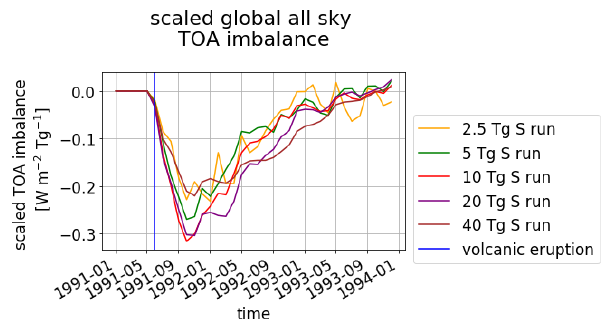
Figure A1. Scaled TOA imbalance for the five volcanically per- turbed EVAens runs (2.5, 5, 10, 20 and 40Tg S). The ensemble means are shown. The vertical blue line marks the eruption time. All TOA imbalances are divided by the mass of emitted sulfur.